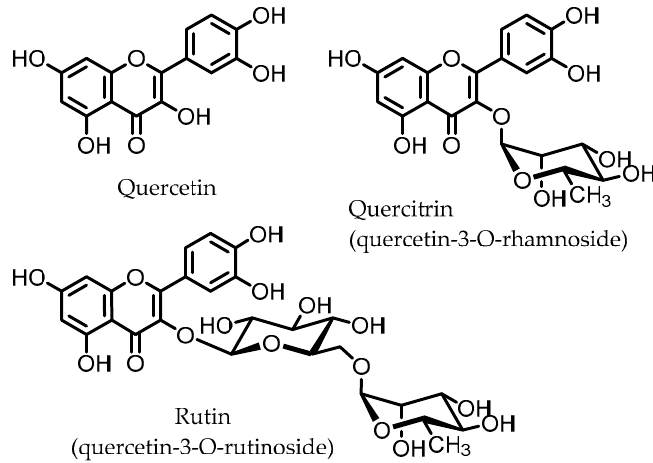
Figure 5. Structures of quercetin, quercitrin, and rutin.